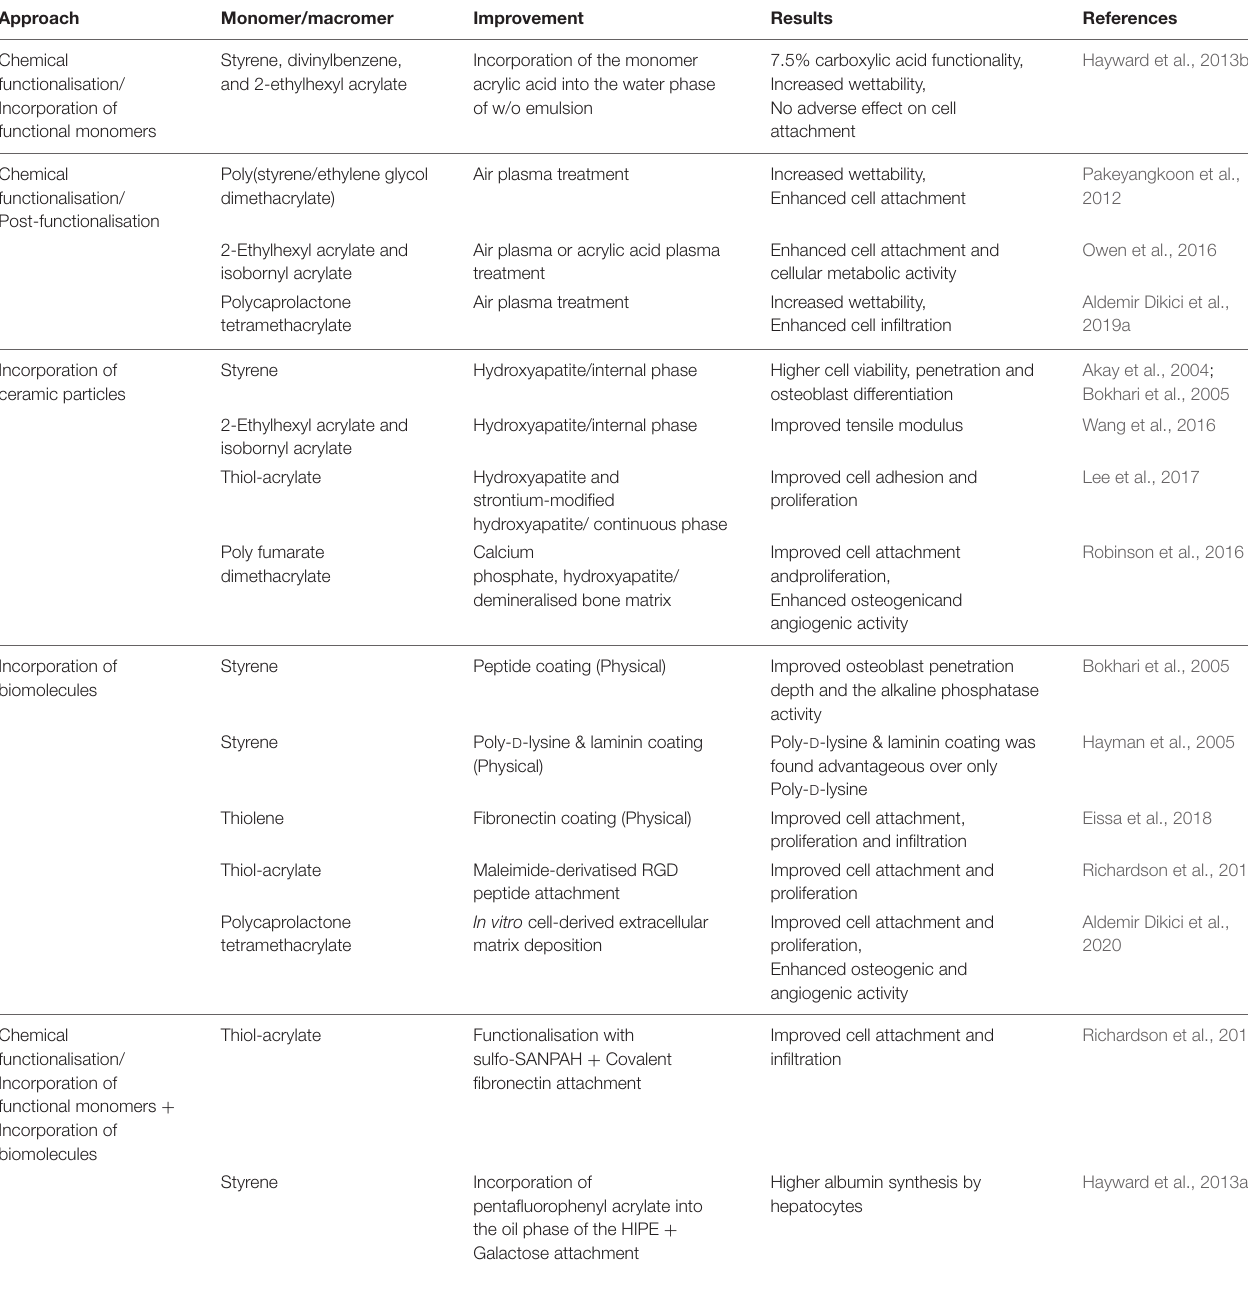
TABLE 2 | Various functionalisation strategies for PolyHIPE scaffolds from the